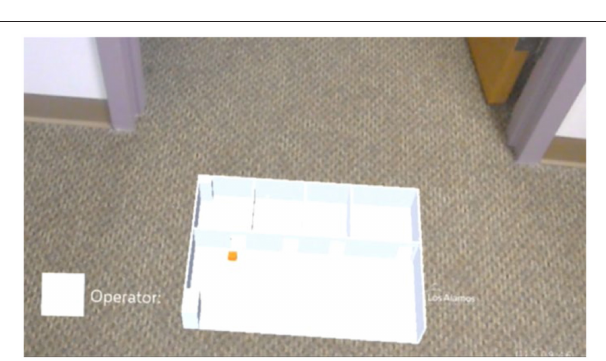
FIGURE 26 | Once the operator gazes at the QR code the operator’s position and pose are recorded in the map.